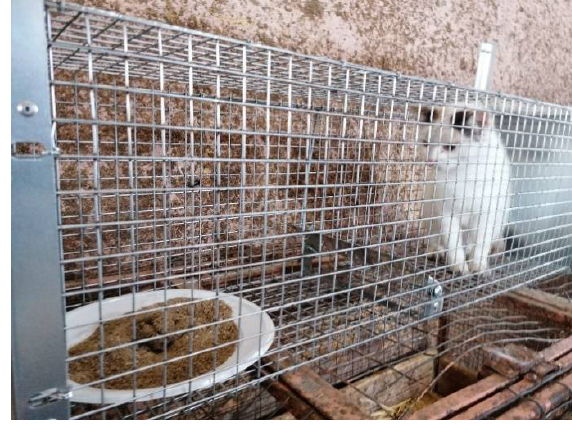
Figure 1. Confinement of a cat by using a trap cage.